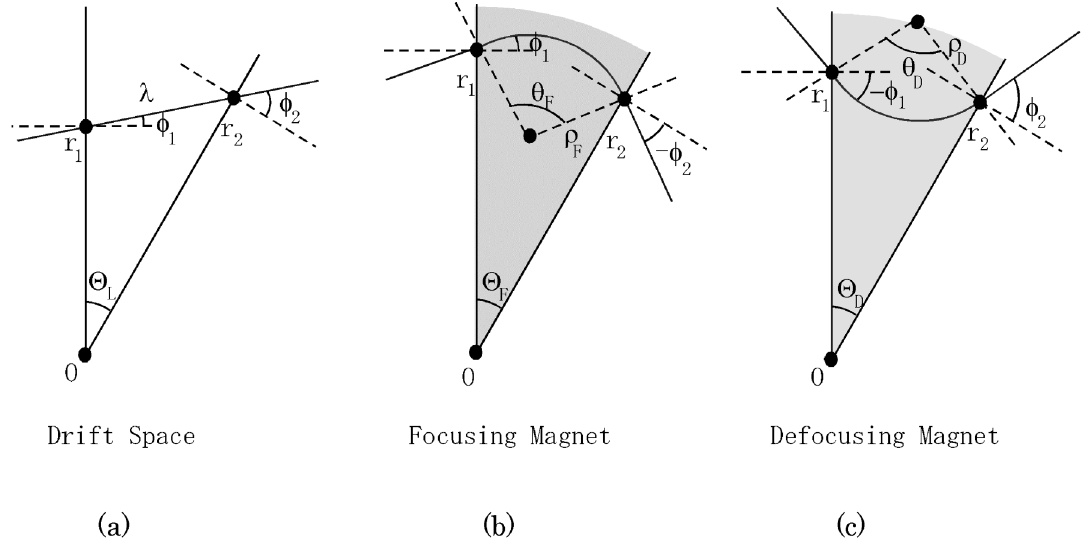
FIG. 1. Basic elements of a radial-sector